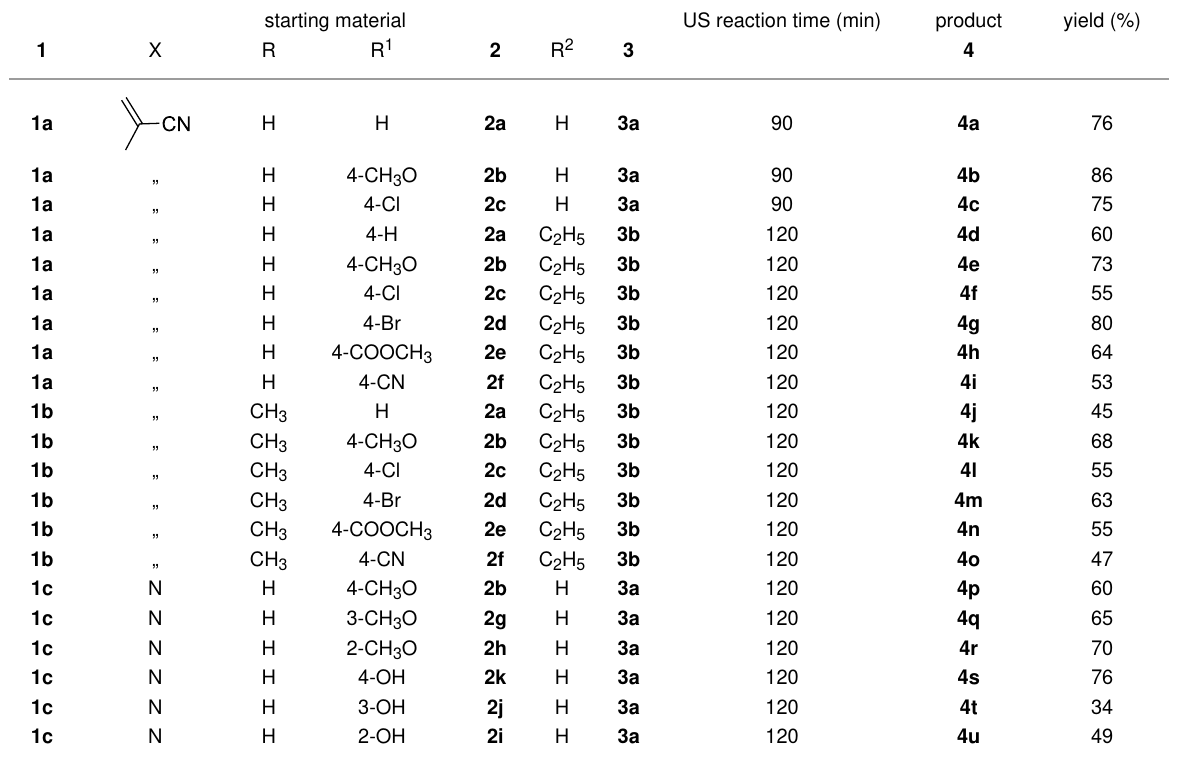
Table 1: Synthesis of compounds 4a – u .